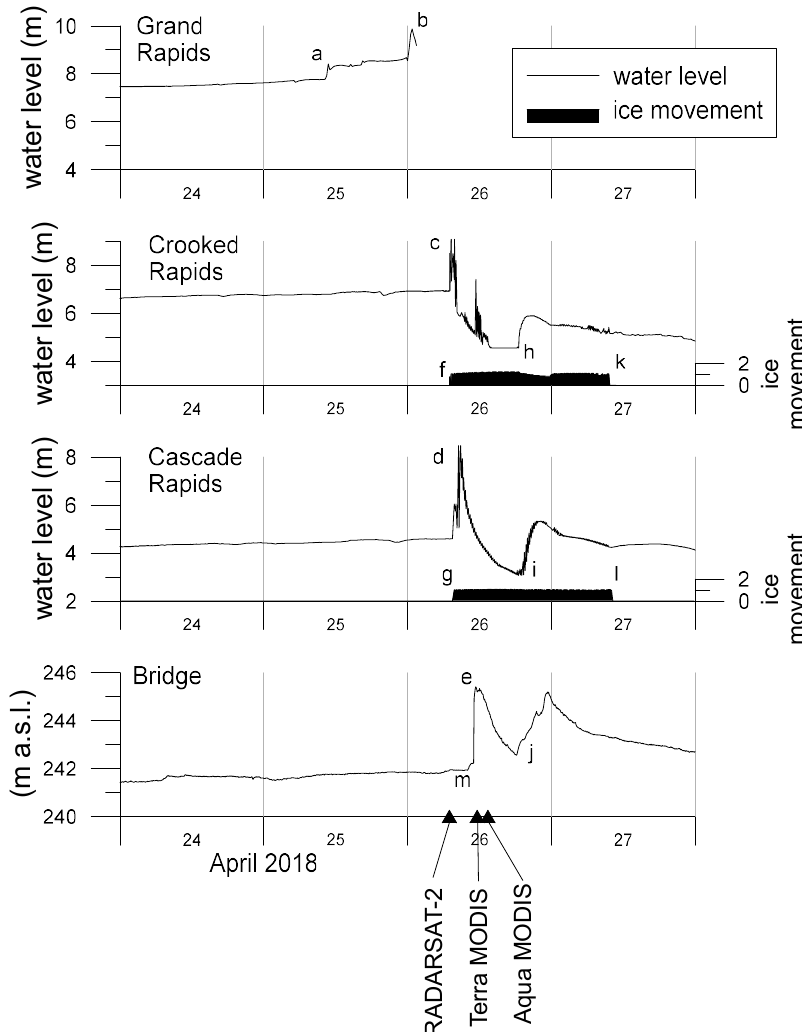
Figure 6. Gauges from hydrographs during the April 2018 breakup event. Remote Sens. 2019 , 11 , x FOR PEER REVIEW